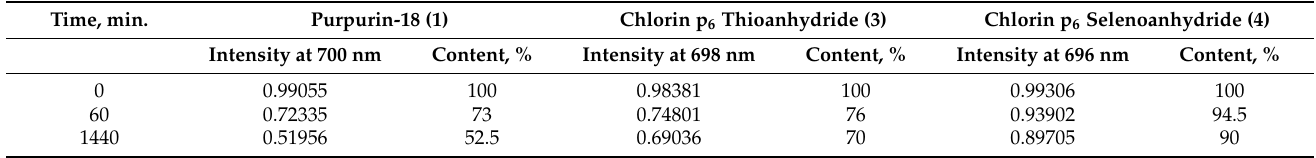
Table 1. Intensity of the absorption maxima of compounds ( 1 ), ( 3 ), and ( 4 ) under acidic conditions at pH = 4. Time, min.